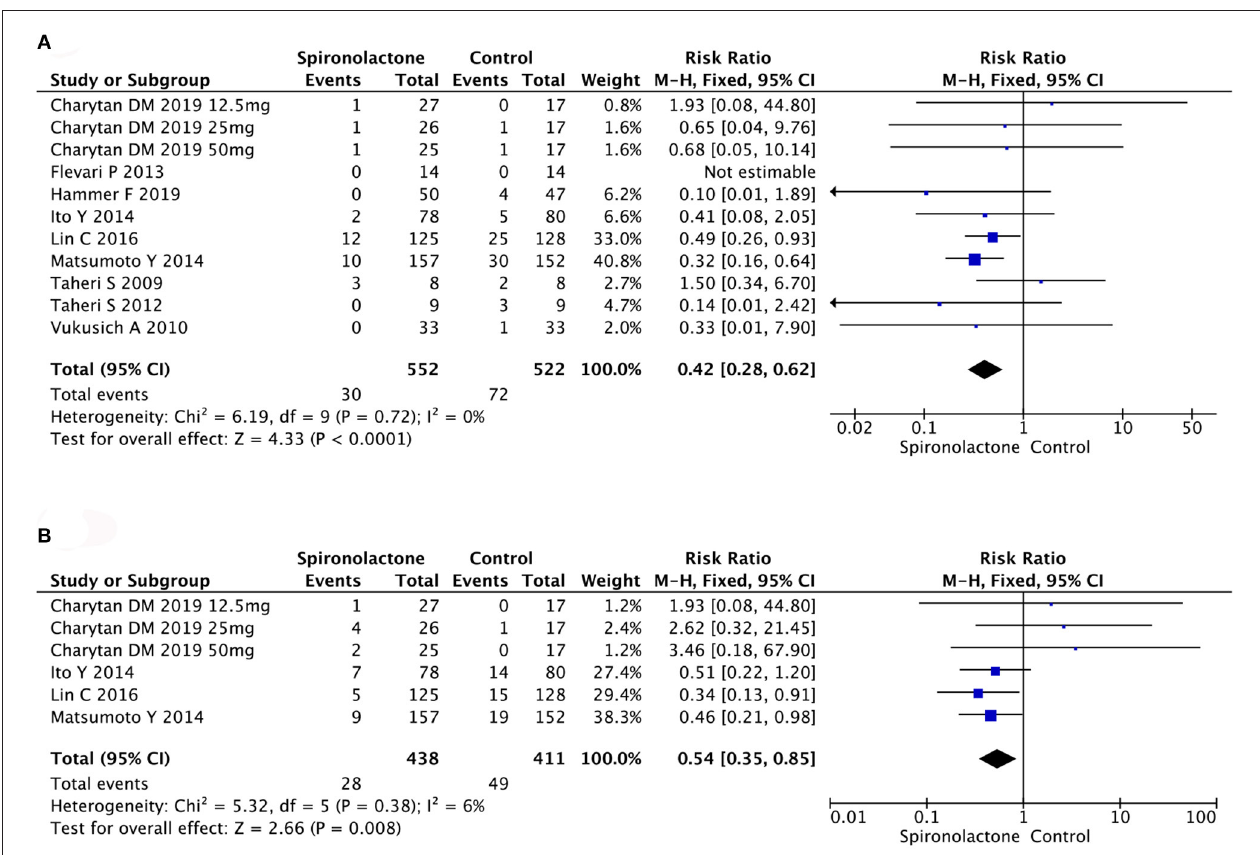
FIGURE 3 | (A) Effect of spironolactone on ACM; (B) Effect of spironolactone on CCV. ACM, all-cause mortality; CCV, cardiocerebrovascular diseases.